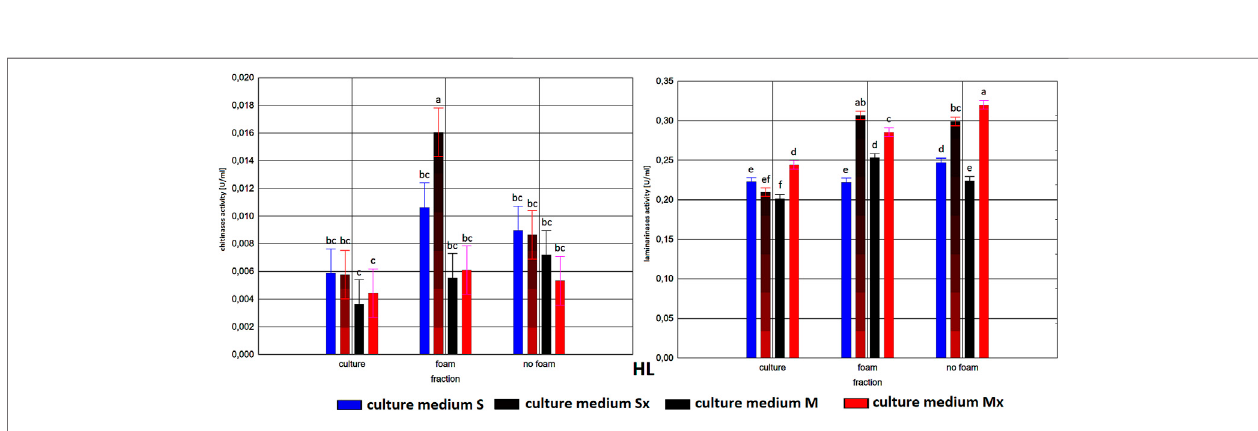
Frontiers in Bioengineering and Biotechnology |